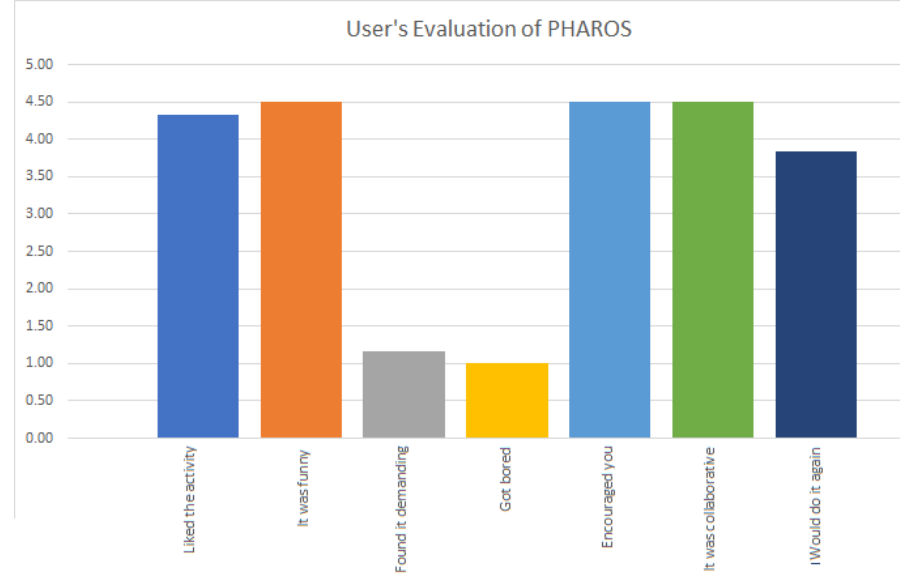
Figure 10. User evaluation of PHAROS on a five-point Likert